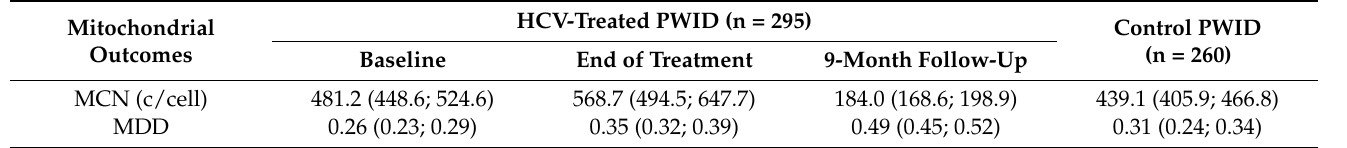
Table 2. MtDNA parameters among HCV-treated PWID and control